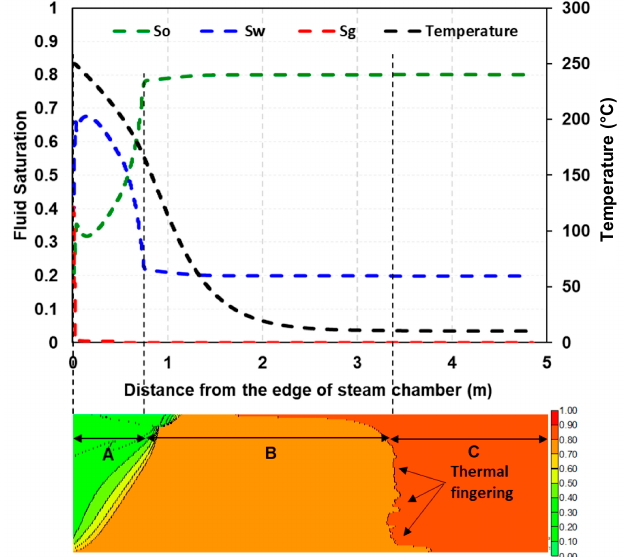
Figure 9. Phase saturations and temperature profiles together with 2D image of the oil saturation profile (below) indicating distinct fluid regions ( A – C ) and thermal fingering observed in a vertical cross section of the HE model. The width of the model has been exaggerated twice for clarity.